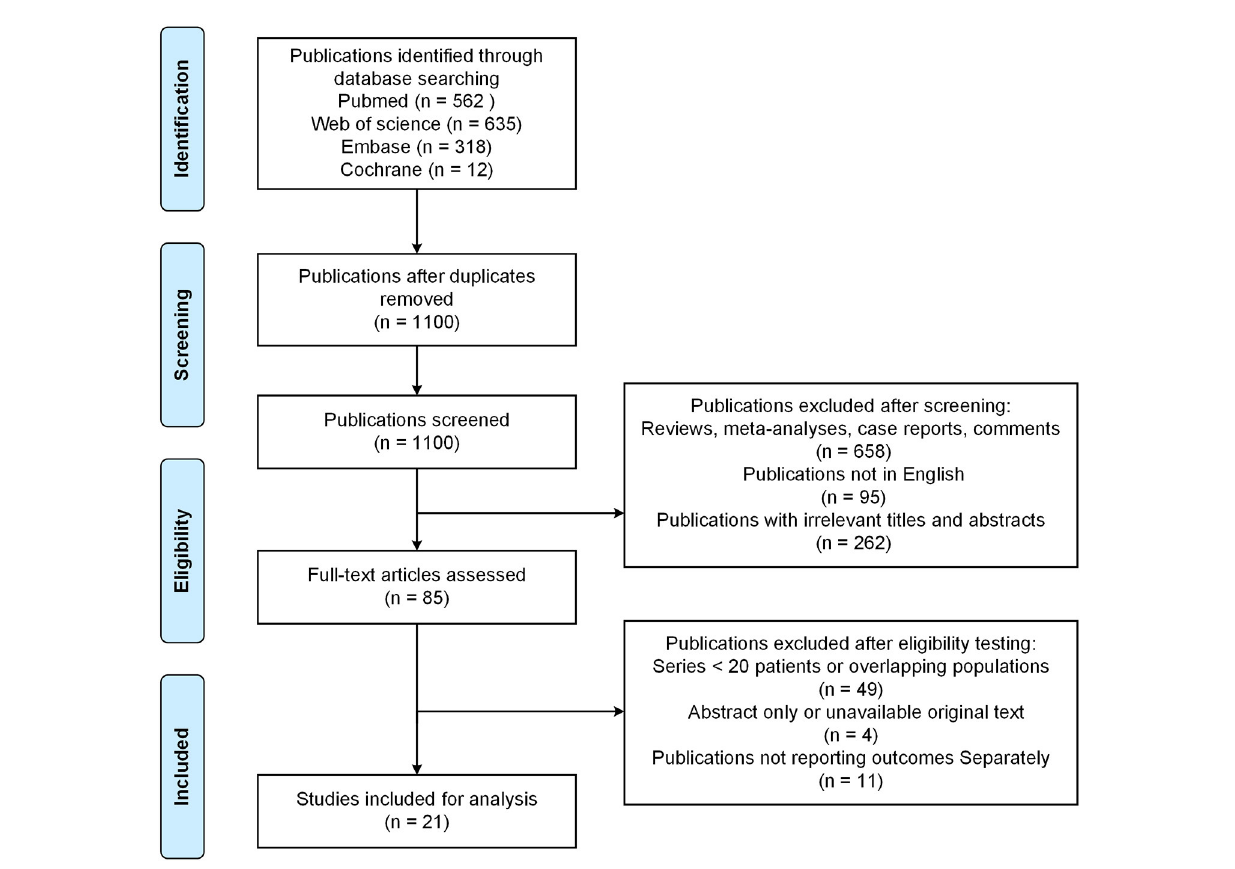
FIGURE1 Preferred reporting items for systematic reviews and meta-analysis (PRISMA) flow diagram of this